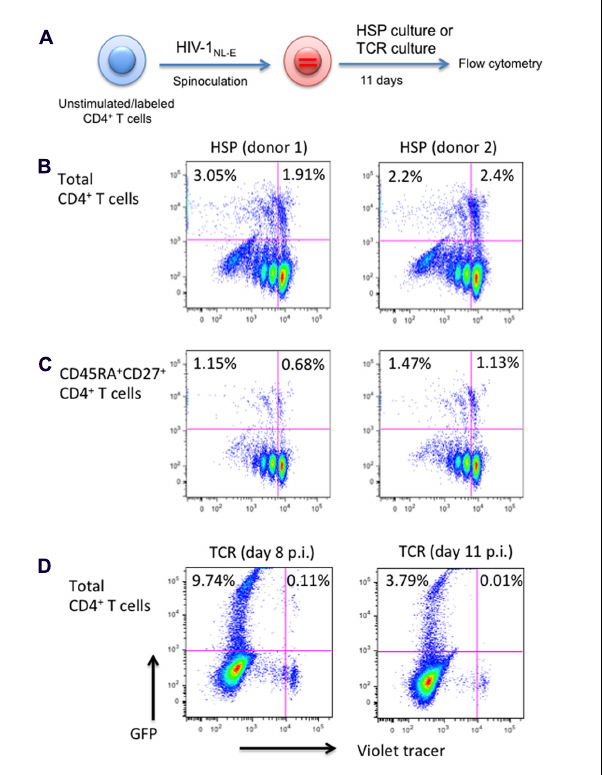
FIGURE 4 | Total and naïve, HSP-cultured CD4 + T cells are both susceptible to productive HIV infection. (A) Outline of experimental strategy. Violet tracer-labeled CD4 + T cells from two blood donors were infected with a wild-type HIV-1 NL − E and cultured under HSP conditions for 11 days. GFP expression and proliferation were analyzed by flow cytometry. (B) Total CD4 + T cells. (C) CD45RA + CD27 + naïve CD4 + T cells. (D) As a control, violet tracer-labeled total CD4 + T cells were infected with HIV-1 NL − E , TCR stimulated with anti-CD3 and anti-CD28, and cultured in the presence of IL-2. Cells were analyzed by flow cytometry at 8 days (left panel) or 11 days (right panel) post infection. Percentages of GFP-positive cells are given for the proliferated and resting cell